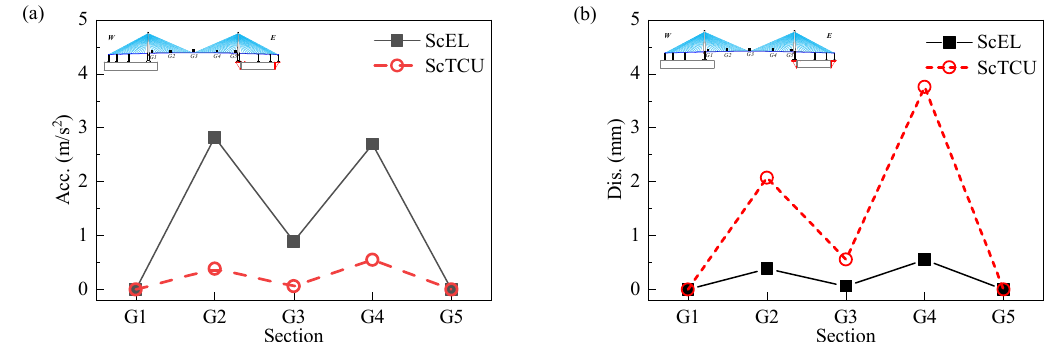
Figure 23. The maximum vertical response of girder for ( a ) acceleration and ( b ) displacement.